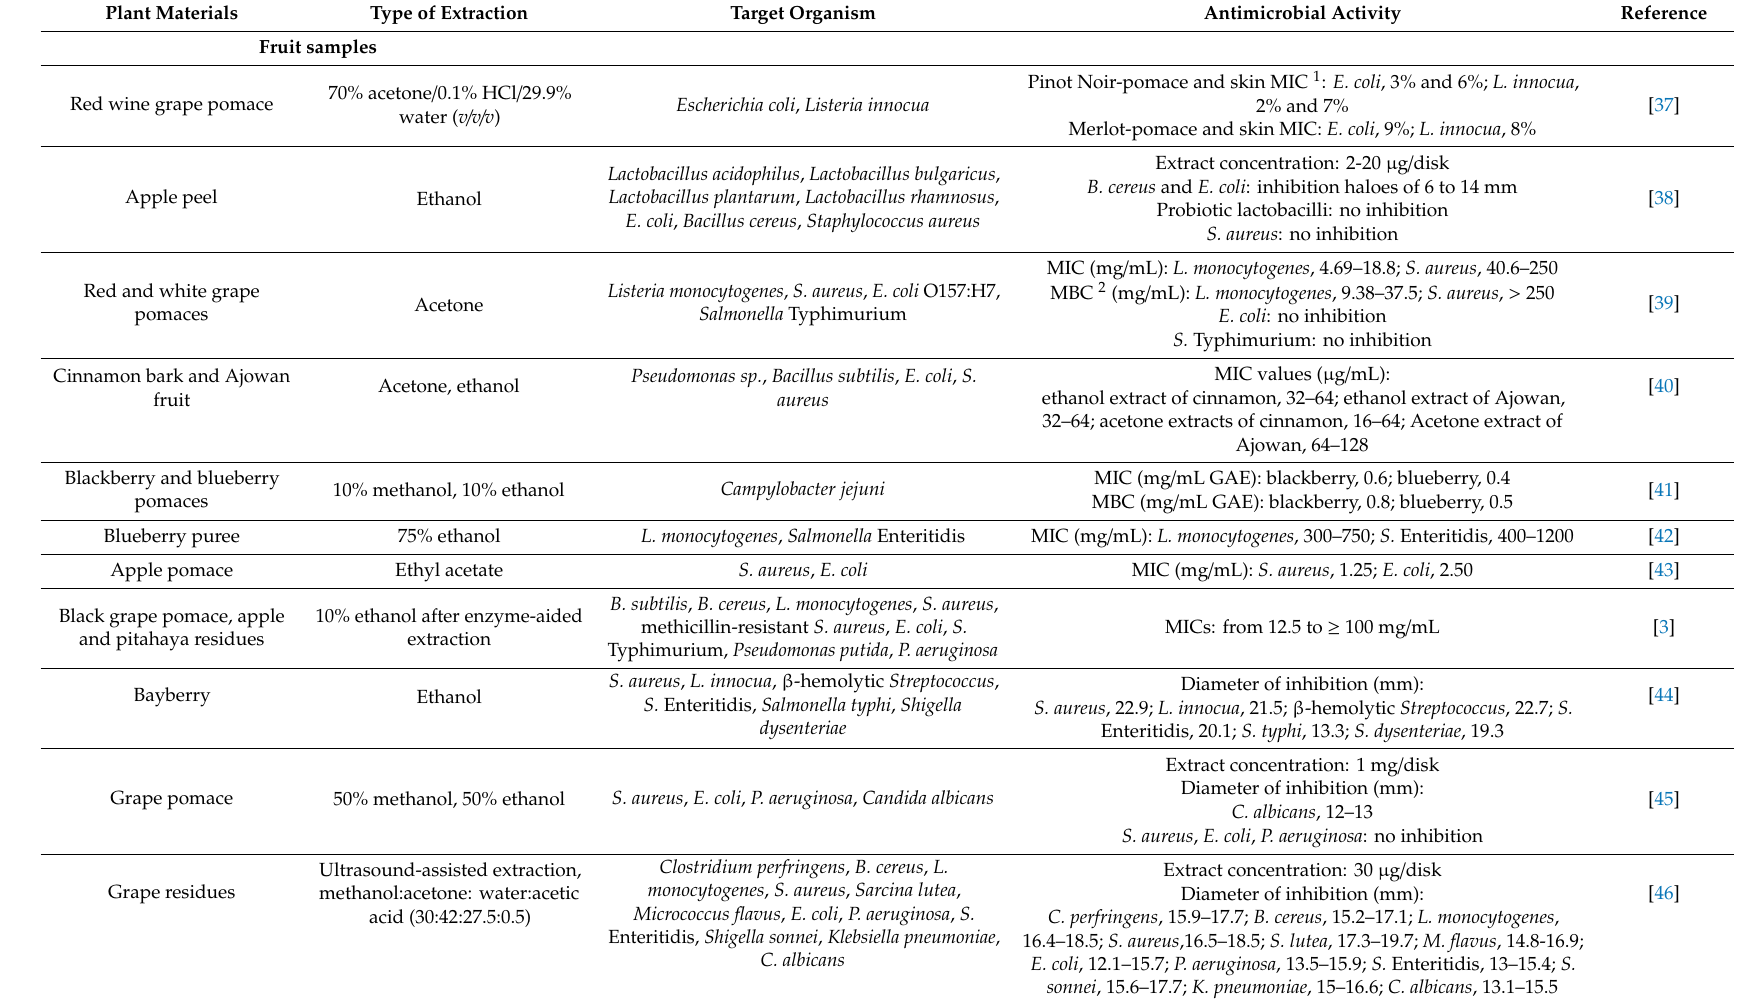
Table 2. Antimicrobial activity of plant phenolic extracts, some